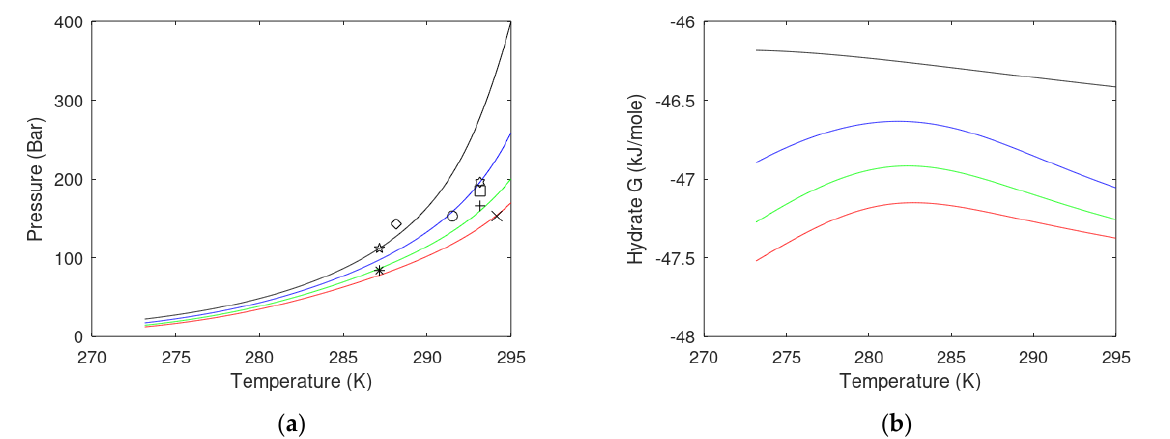
Figure 5. ( a ) Calculated pressure-temperature stability limits for hydrates formed from pure CH 4 (black), from 99 mole% CH 4 and 1 mole% H 2 S (blue), from 98 mole% CH 4 and 2 mole% H 2 S (green), and from 97 mole% CH 4 and 3 mole% H 2 S (red). Single points refer to Table 1 condition for different sites. The various symbols represent different site numbers on Table 1. The circle is 1, the square is 12, the diamond is 10, the pentagram is 2, the hexagram is 3, the star is 4, the plus is 9, and the cross is 8. Regarding temperature, 10 and 5 are almost identical in the same temperature and 1 bar higher pressure in 10 relative to 5. ( b ) Molar Gibbs free energy for hydrate from pure CH 4 and the 3 mixtures of CH 4 with H 2 S.